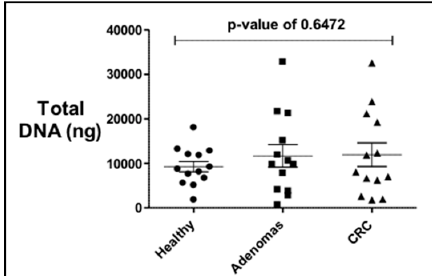
Figure 1. Total bacterial DNA extracted from stool samples of controls, adenomas and colorectal cancer (CRC) individuals shows no statistical difference by diagnosis. There is a higher variability in the adenomas and CRC. Diseases 2019 , 7 , x FOR PEER REVIEW